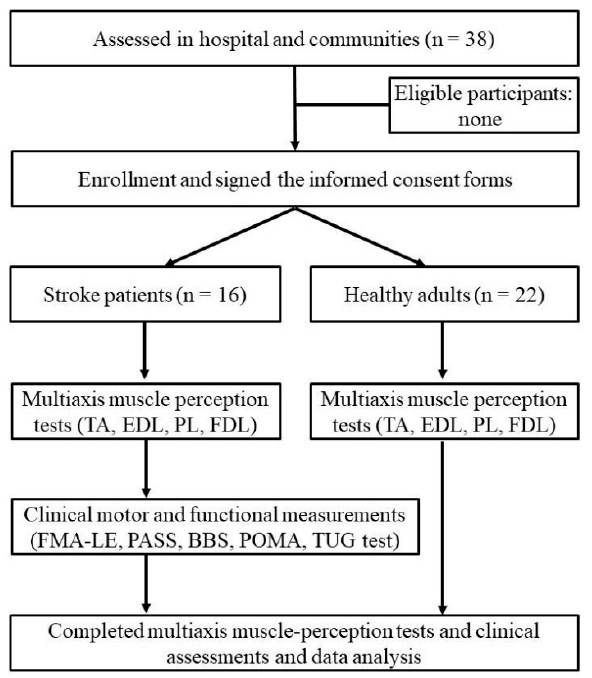
Figure 1. Flowchart for participant enrollment and outcome measurements.